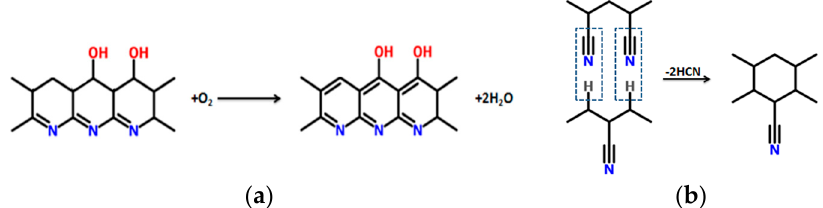
Figure 2. Reactions in presence of oxygen at 300–400 °C of ( a ) aromatization and ( b ) intermolecular cross-linking.